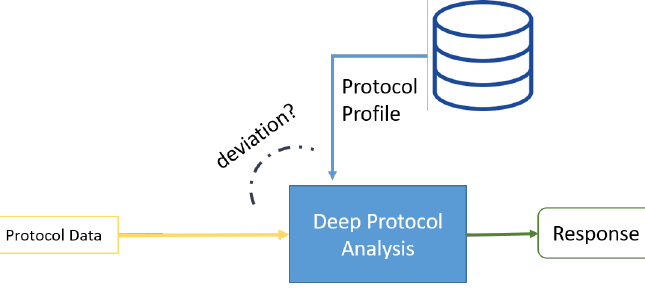
Figure 4. Diagram of a generic stateful-protocol